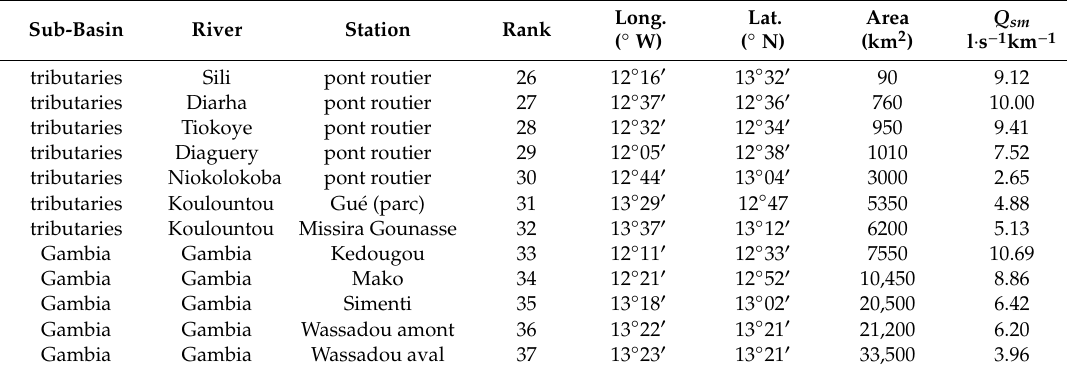
Table 2. Gambia basin—list of stations analyzed, with their catchment area and mean specific discharge Q sm over the period 1970–1979.